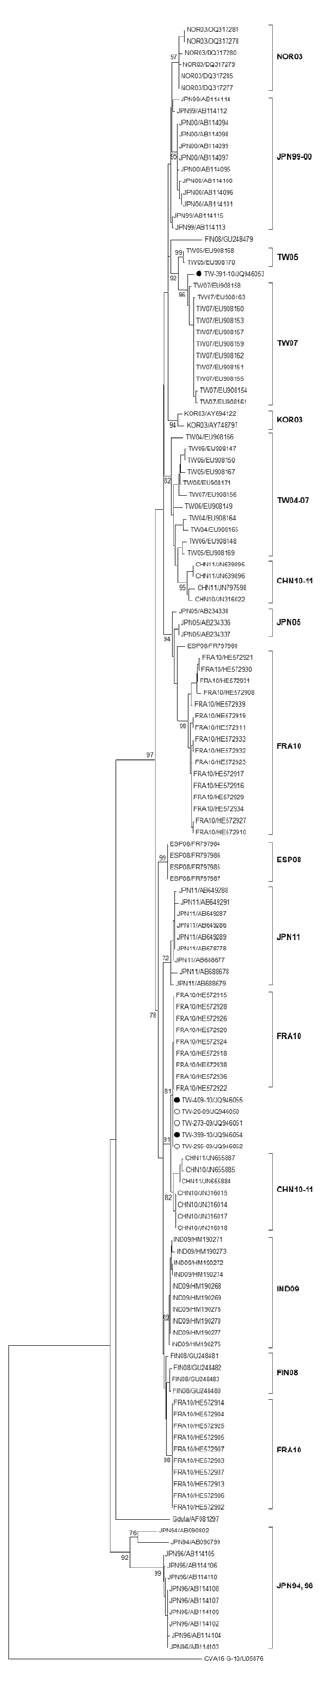
Figure 1. Monthly Distribution of Cox-A6 infection children in 2009 and